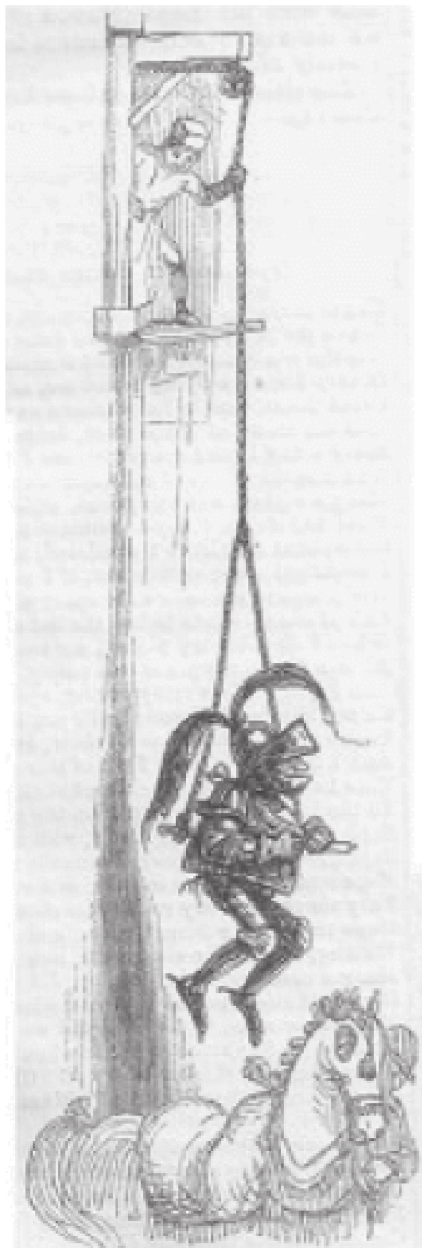
Figure 3: A bit more, punch, 1845